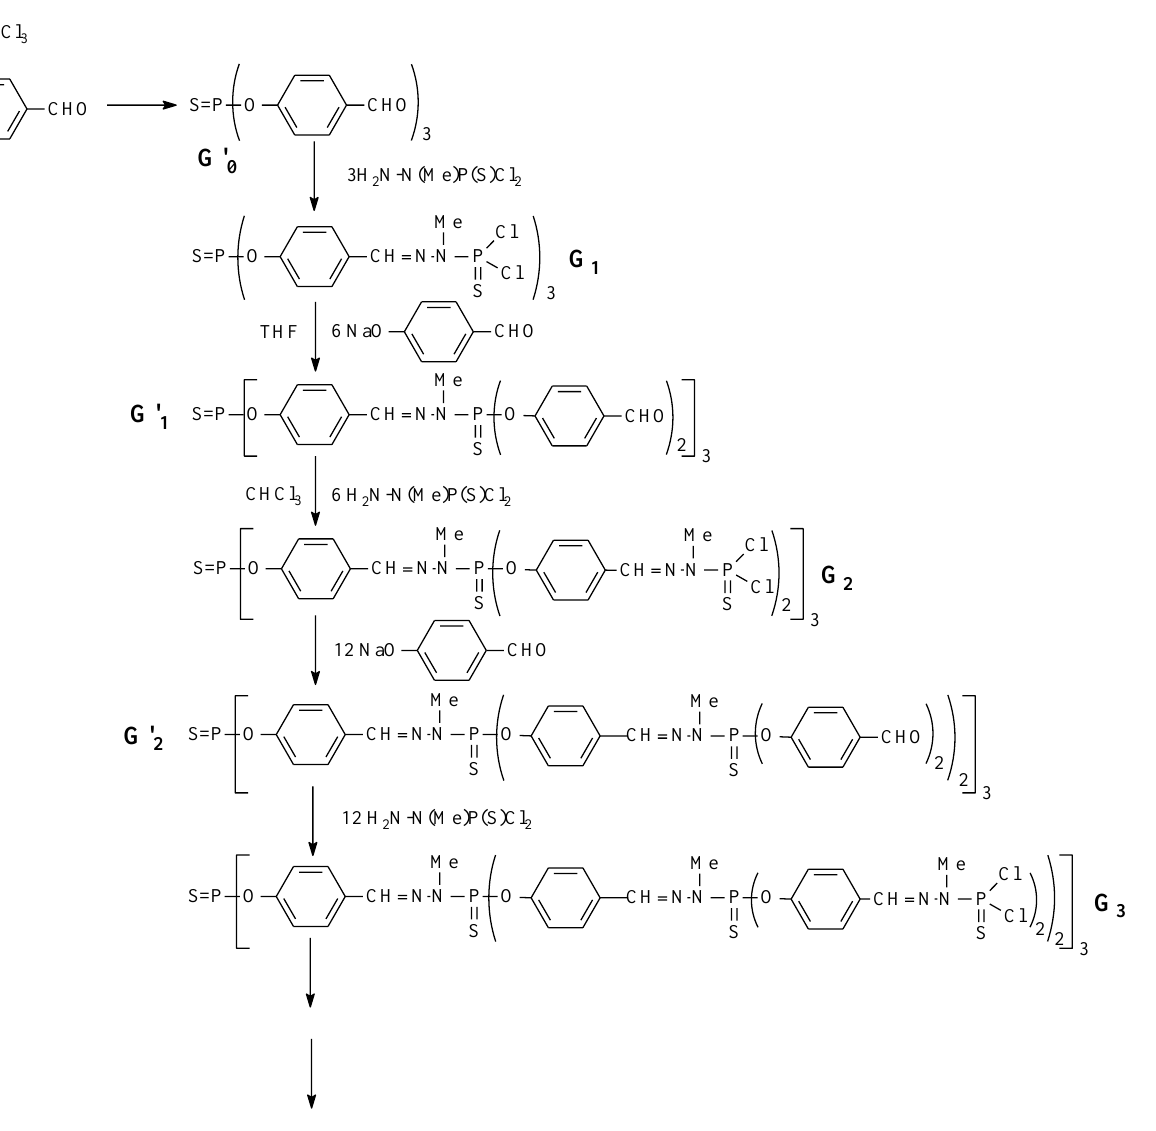
Figure 7. The sequence of reactions is repeated to produce 12th-generation dendrimers.